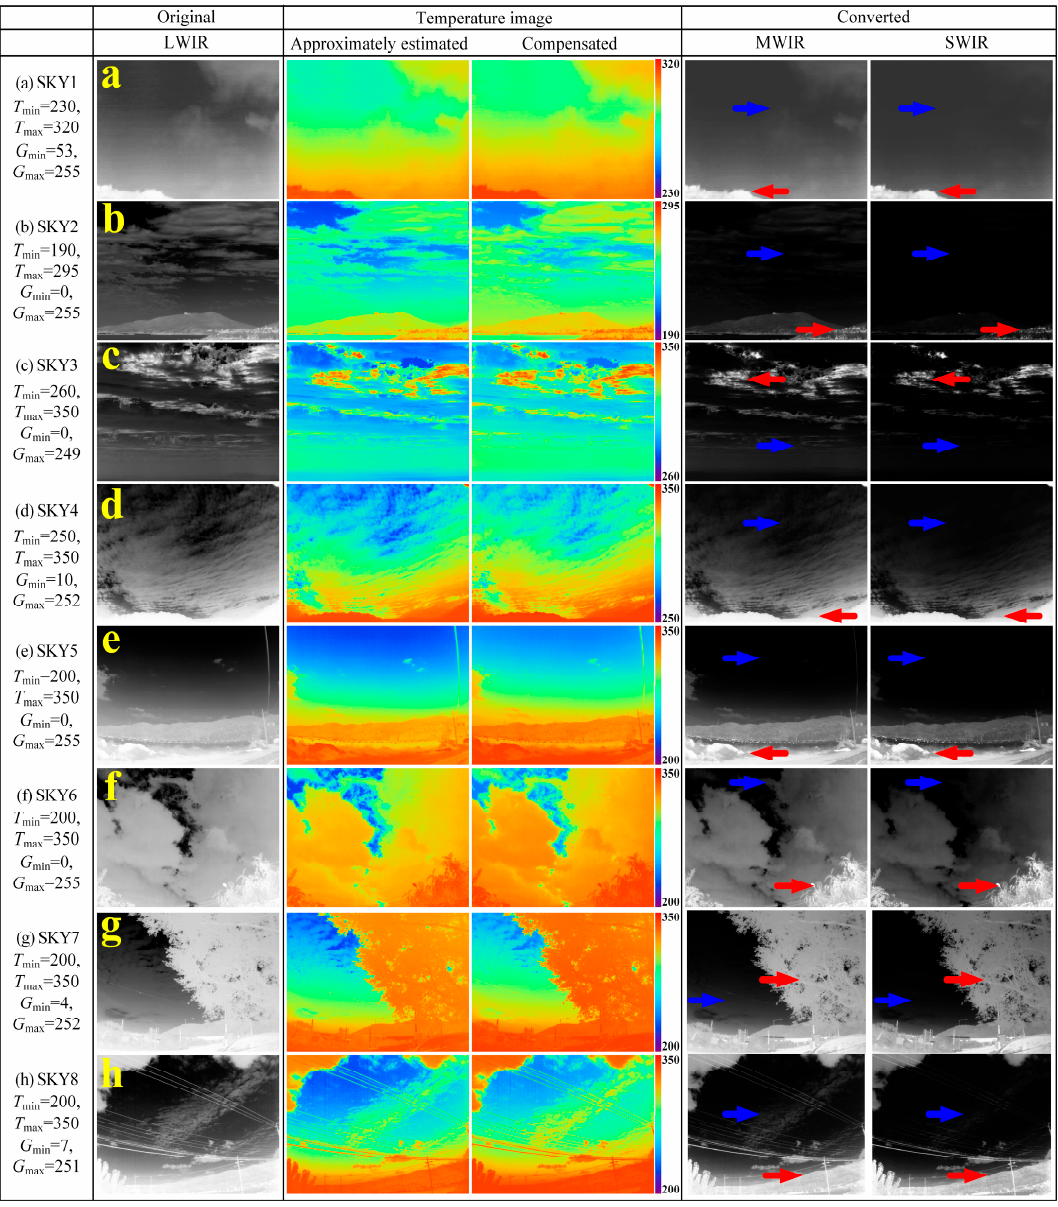
Figure 10. MWIR and SWIR conversion results using the proposed method for various sky background images, ( a – h ) SKY1~SKY8.